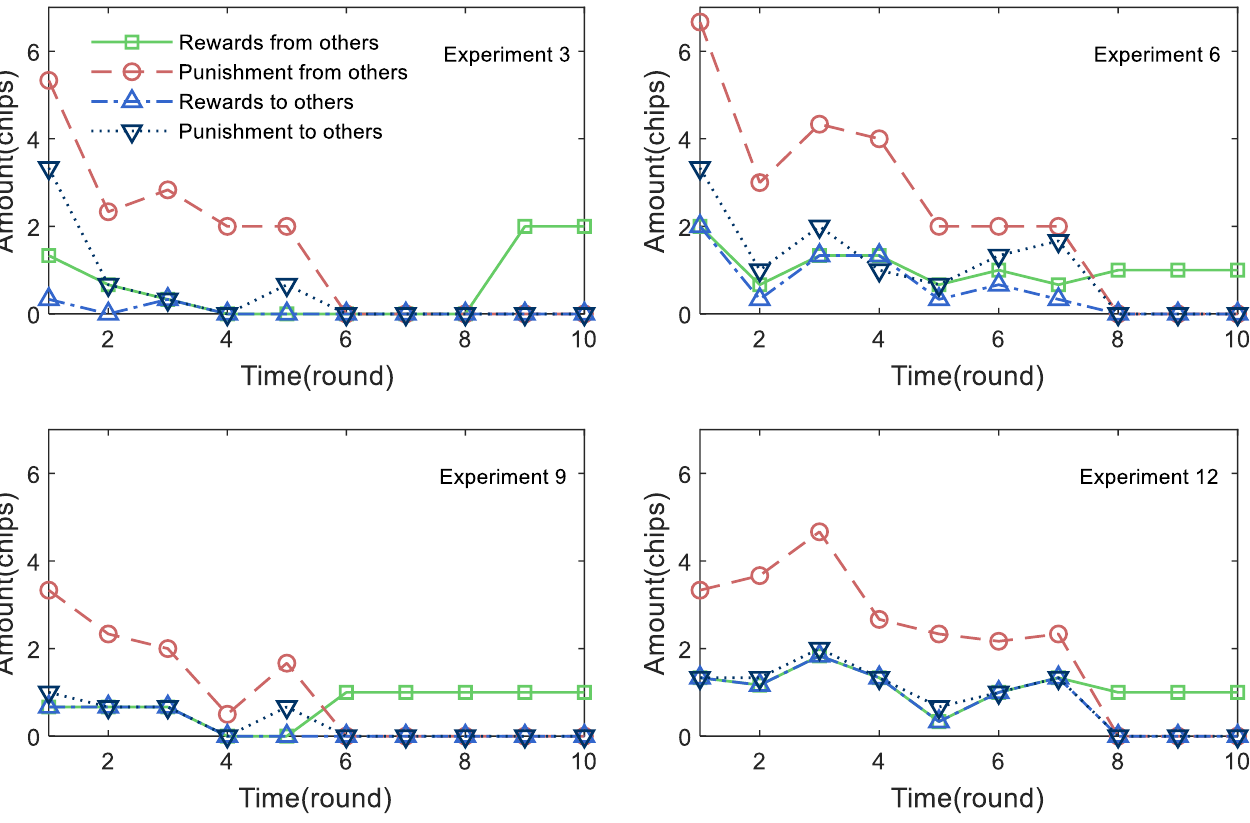
Figure 9. Amounts of reward and punishment implemented or received.